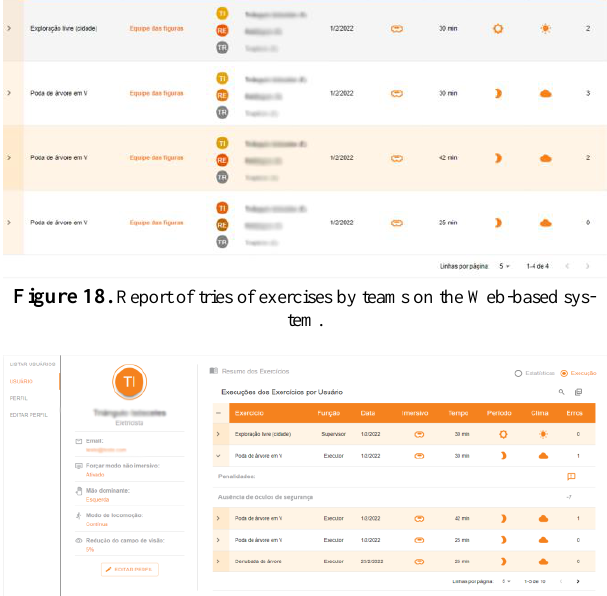
Figure 19. Report of the tries of exercises performed by an electrician on the Web-based